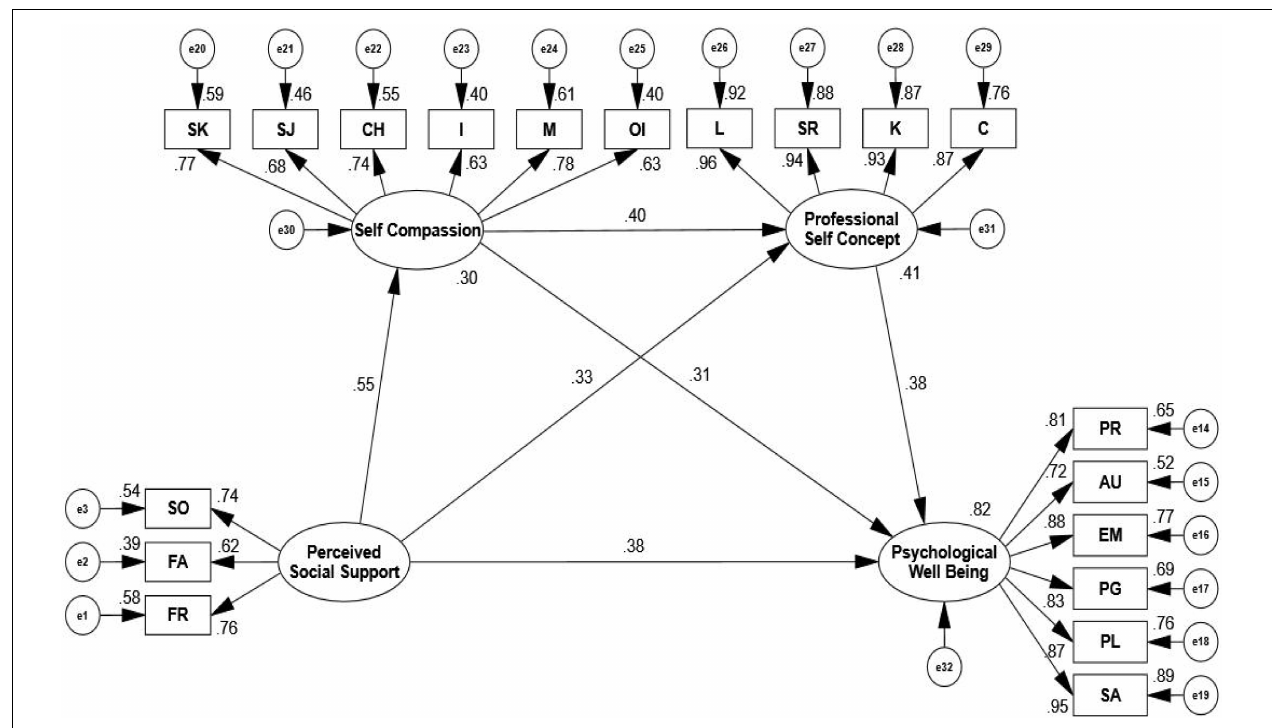
FIGURE 1 | Standardized path coefficient of Structural Equation Model. Self-compassion and professional self-concept in sequence mediated the relationship of perceived social support on psychological wellbeing (PWB). SK, self-kindness; SJ, self-judgment; CH, common humanity; I, isolation; M, mindfulness; OI, overidentification; C, care; K, knowledge; SR, staff relations; L, leadership; SO, significant others; FA, family; FR, friends; PR, positive relations with others; AU, autonomy; EM, environmental mastery; PG, personal growth; PL, purpose in life; SA, self-acceptance.